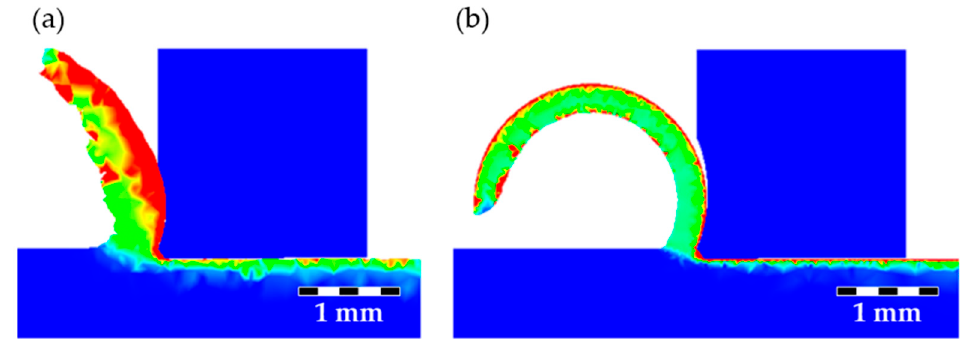
Figure 6. Bending of the chip as a result of the radius of curvature with ( a ) R = 1 mm; ( b ) R = 1.4 mm.